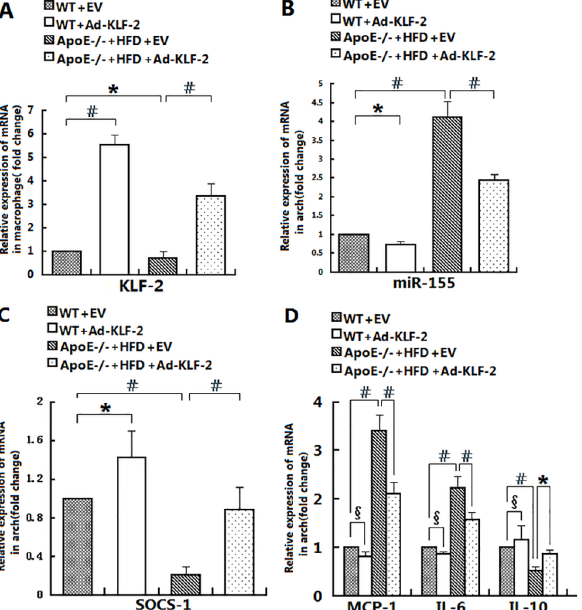
Fig 5. The effects of KLF2 on miR-155/SOCS-1 and cytokine gene expression in pro-inflammatory macrophages. Murine resident peritoneal macrophages were obtained from the four aforementioned groups at the time of euthanization. The mRNA expression levels of KLF2 (A), miR-155 (B), SOCS-1 (C) and cytokines (D) in these cells were determined by RT-PCR (n = 5; #, * , and δ indicate p < 0.001, p < 0.05 and p > 0.05, respectively, for the indicated